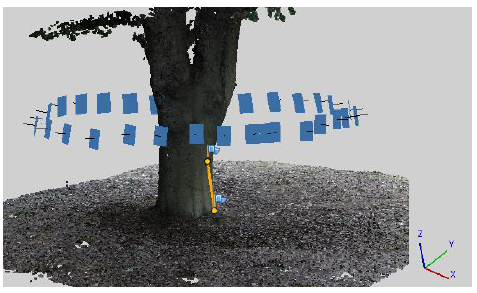
Figure 3 . Reconstructed model of the tree, with the measurement of a check distance.